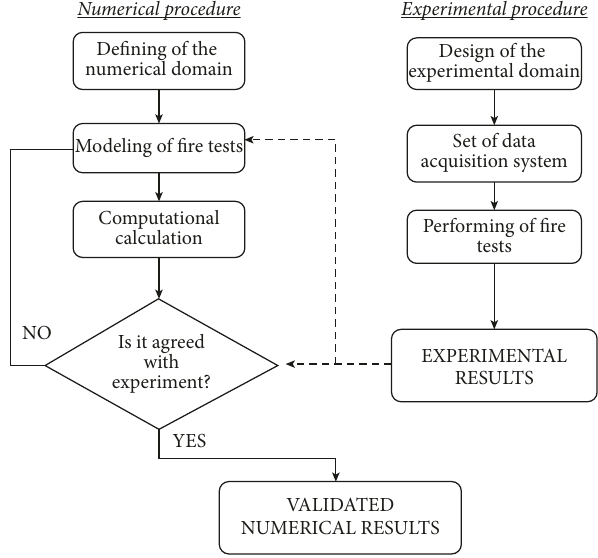
Figure 3: Steps of numerical simulation of fire tests.